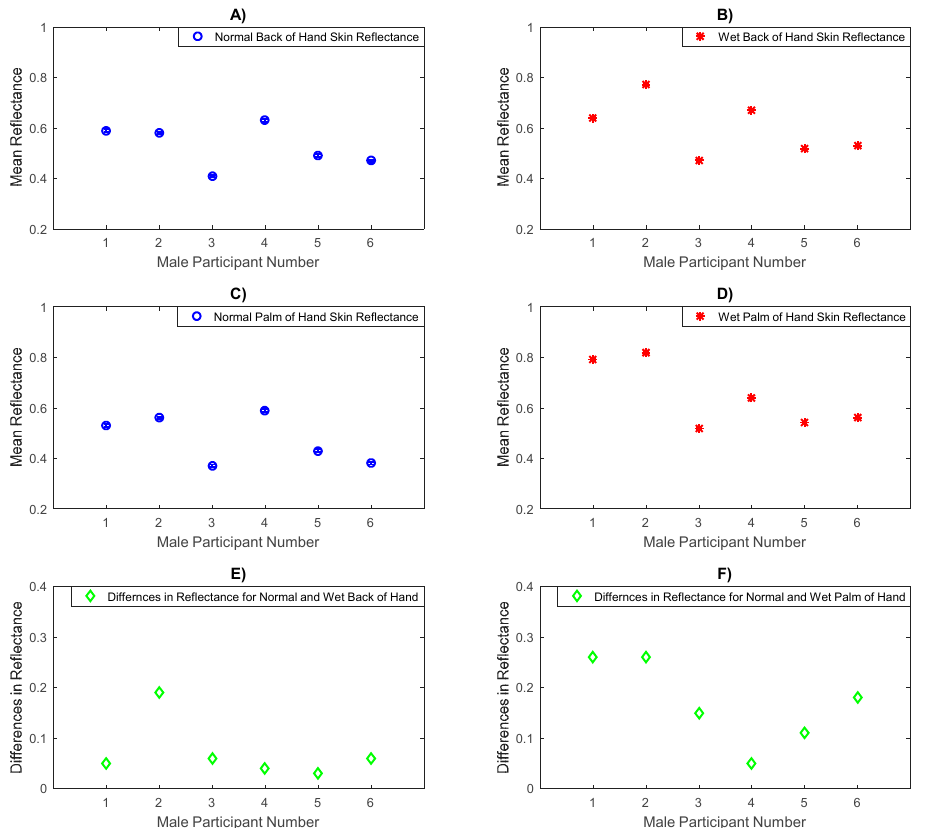
Figure 12. Measurements of human skin reflectance on normal and wet back of hand and palm of hand skin for a sample of 6 male participants. The mean di ff erences in reflectance between the normal ( A ) and the wet back of hand skin ( B ) are in the range of 0.03 to 0.19 as illustrated in ( E ) whereas the mean di ff erences in reflectance between the normal ( C ) and the wet palm of hand skin ( D ) are in the range of 0.05 to 0.26 as illustrated in ( F ).